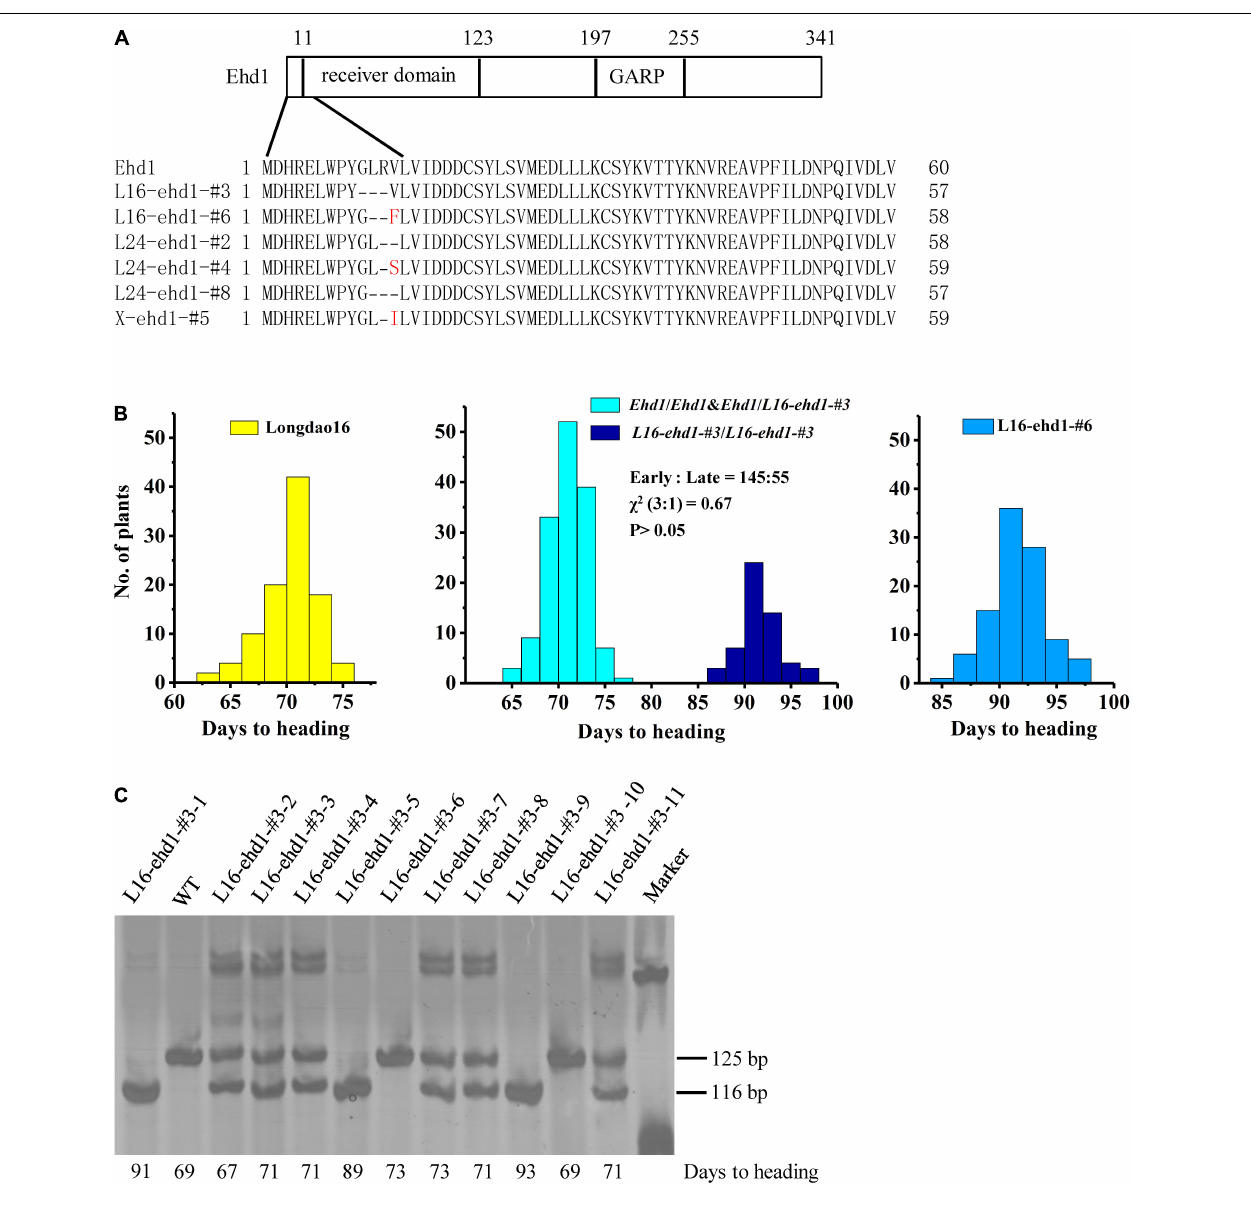
FIGURE 3 | Minor in-frame deletion mutations in the receiver domain region of Ehd1 caused moderate delays of heading date in rice. (A) Schematic diagram of the domains within Ehd1 and comparison of deduced amino acid sequences of Ehd1 in the six in-frame deletion mutant lines L16-ehd1-#3, L16-ehd1-#6, L24-ehd1-#2, L24-ehd1-#4, L24-ehd1-#8, and X-ehd1-#5. Deletion and substitution are indicated by dash and red letter, respectively. (B) Frequency distributions of days to heading of Longdao16 (left), T 1 segregating population of L16-ehd1-#3 (middle), and T 1 homozygous line L16-ehd1-#6 (right). About 100 plants, 200 plants and 100 plants of Longdao16, L16-ehd1-#3, and L16-ehd1-#6, respectively, were investigated. (C) Examples of genotyping and phenotyping results showing co-segregation of the moderately delayed flowering phenotype with the homozygous L16-ehd1-#3 allele in T 1 population of L16-ehd1-#3. Each individual plant was analyzed by PCR amplification using allele-specific primers. The 125 and 116 bp fragments represent wild-type Ehd1 and L16-ehd1-#3 alleles, respectively. Days to heading of each detected plant are shown at the